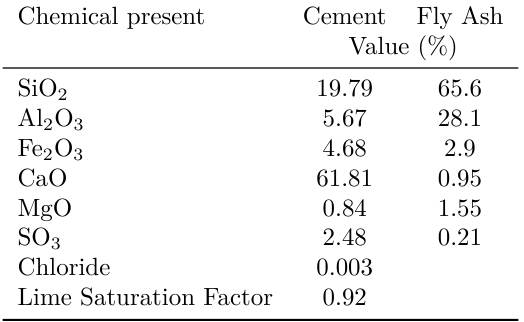
Table 1. Chemical compositions of